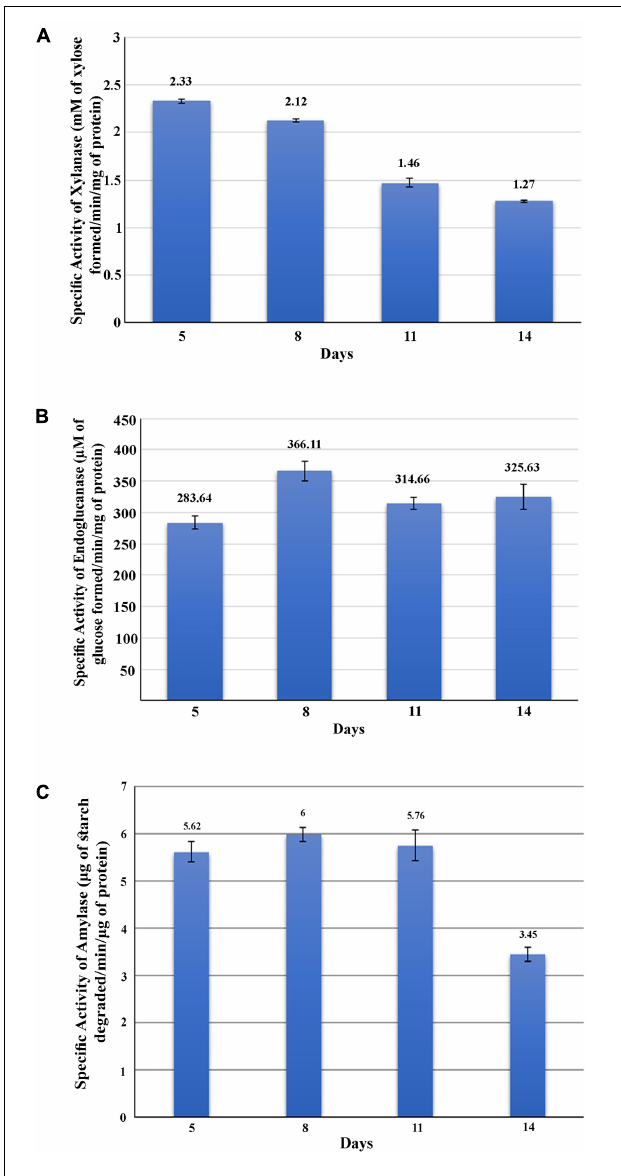
FIGURE 4 | Activity analysis of xylanase, endoglucanase, and amylase enzymes. Secretome of M. phaseolina was collected 5, 8, 11, and 14 days after inoculation in solid-state culture, and xylanase, endoglucanase, and amylase activities were determined using spectrophotometric assay. (A) Determination of xylanase activity. Specific activity of xylanase was expressed as mM of xylose formed per minute per milligram of secretome protein. (B) Determination of endoglucanase activity. Specific activity of endoglucanase was expressed as µ M of glucose formed per minute per milligram of secretome protein. (C) Determination of amylase activity. Specific activity of amylase was expressed as micrograms of starch degraded per minute per milligram of secretome